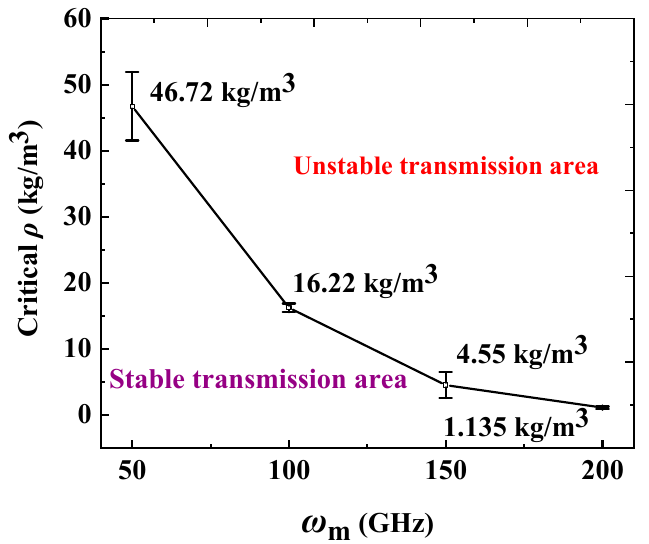
Figure 4. The schematic diagram of the stable and unstable transmission areas of the RTS.